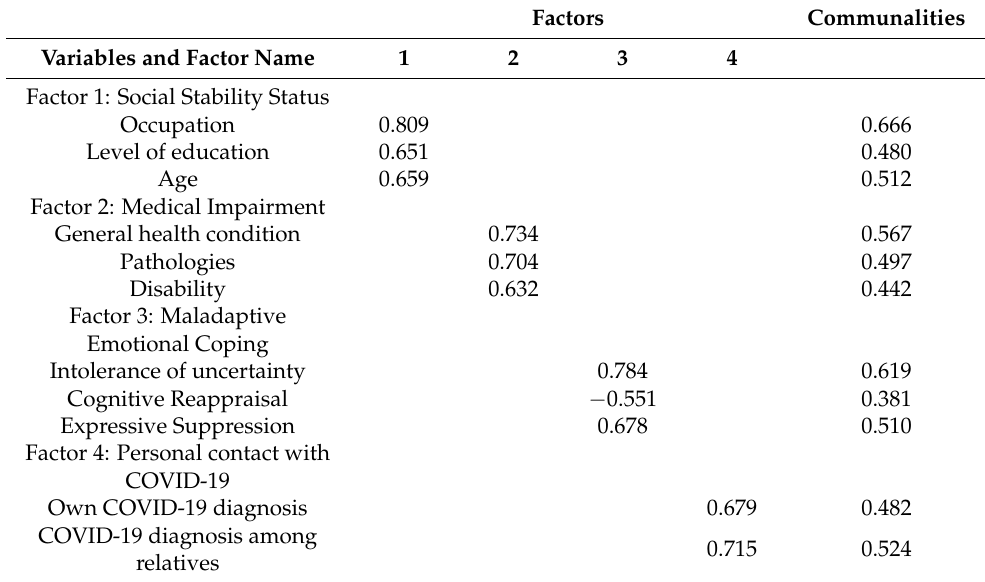
Table 3. Factor loadings and communalities for the rotated matrix.